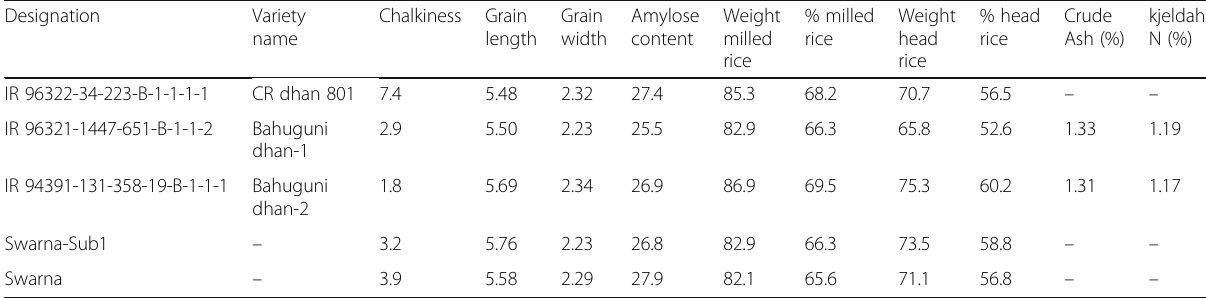
Table 6 Grain quality parameters of the varieties released in India and Nepal in Swarna background in